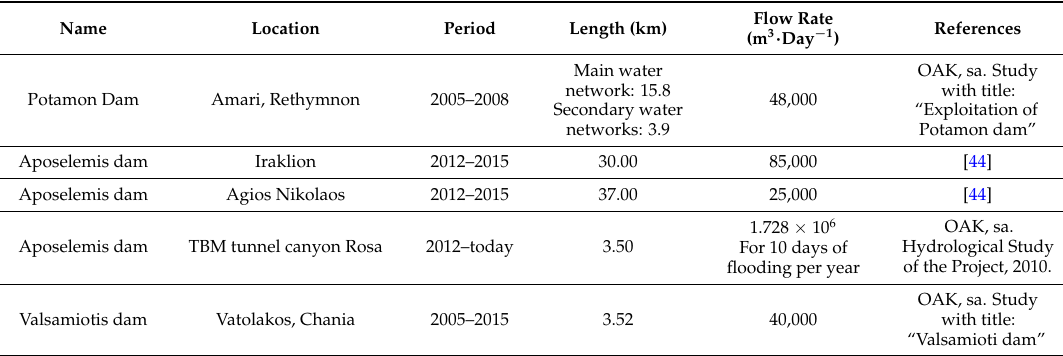
Table 5. Aqueducts in modern times (Adapted from Voudouris et al.